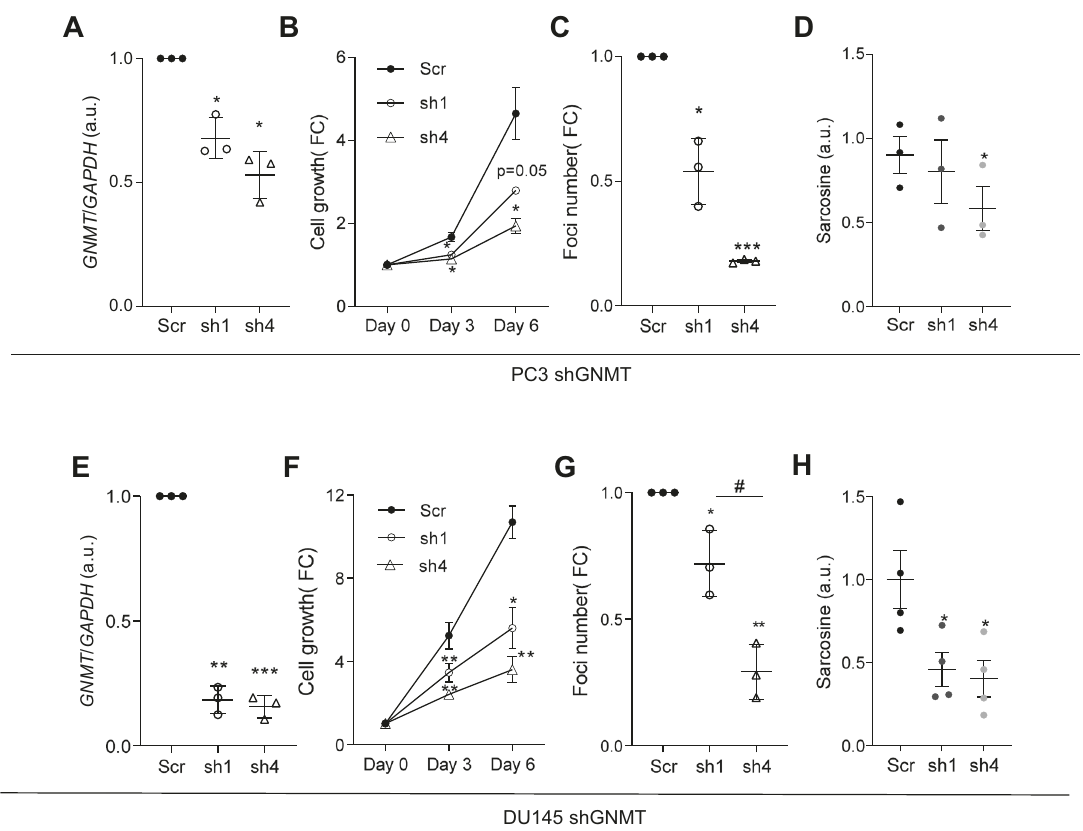
Fig. 4 Impact of genetic Gnmt modulation in prostate cancer pathogenesis. A – D , Effect of GNMT silencing on mRNA levels ( A ), cell number ( B ), foci formation ( C ), and sarcosine levels by LC/MS ( D ) in PC3 cells ( n = 3). E – H , Effect of GNMT silencing on mRNA levels ( E ), cell number ( F ), foci formation ( G ), and sarcosine levels by LC/MS ( H ) in DU145 cells ( n = 3 – 4). Data are represented as mean with SEM. scr: scramble short hairpin; sh1 and sh4: two different short-hairpins targeting GNMT ; p , p value; * p < 0.05; ** p < 0.01; *** p < 0.001. Statistic test: One Sample ( A , C , E , G ) and or one-tailed paired ( B , D , F , H ) Student T -test was used for data analysis.